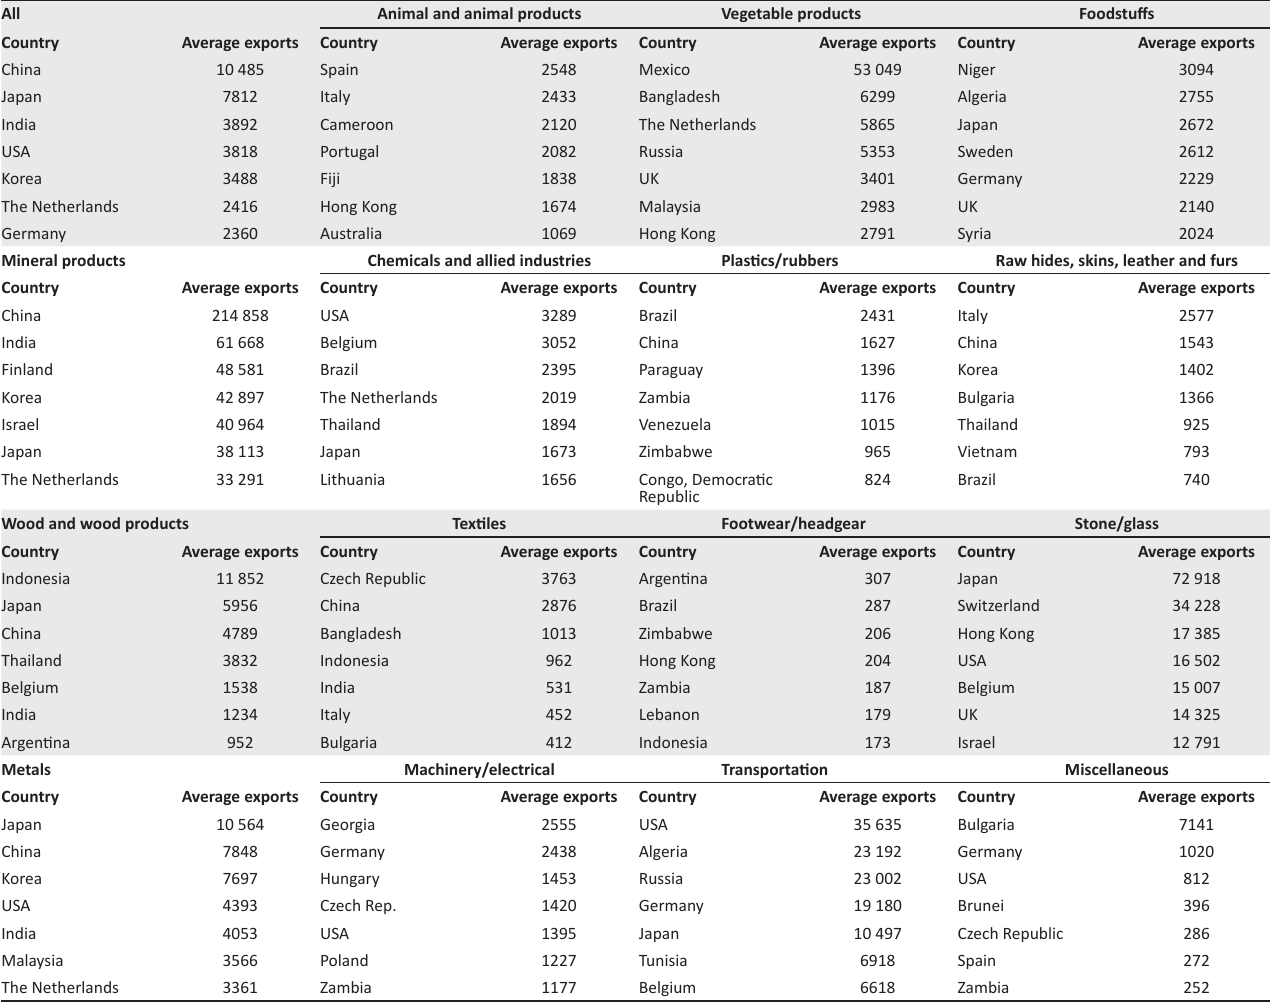
TABLE 2-A1: Main importing countries by